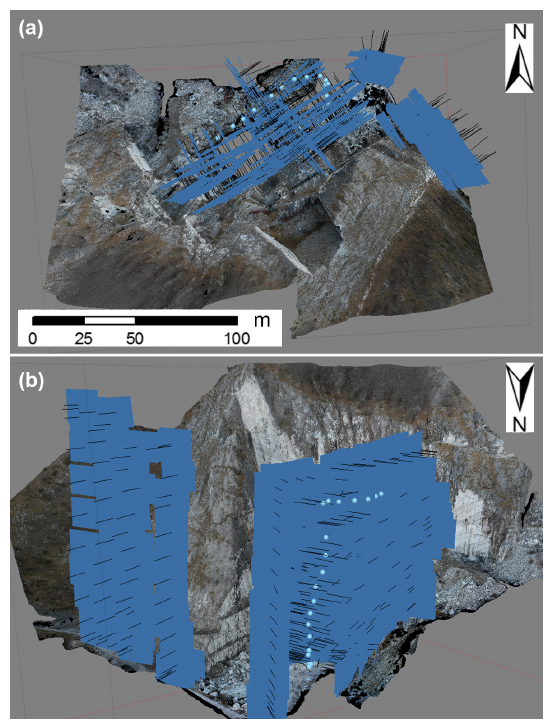
Figure 5. Plan view (a) and perspective view (b) of the RPAS frontal surveys (blue rectangles correspond to the photographs lo- cations, black lines to normals). Corresponding 3-D point clouds produced by the photogrammetric processing of natural colour dig- ital images are shown in